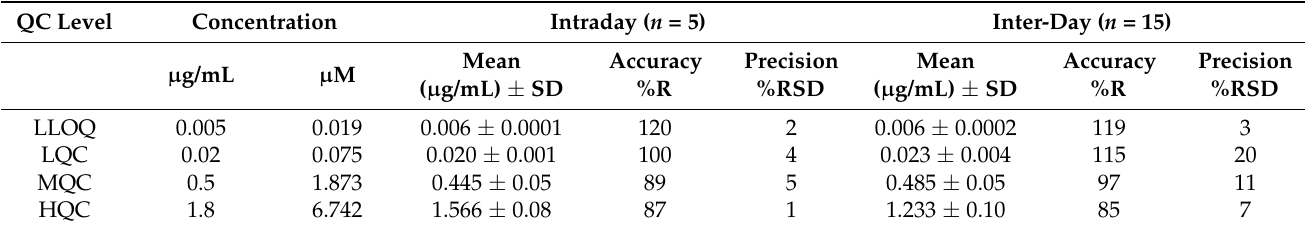
Table 2. Intra- and inter-day precision and accuracy of adenosine in spiked blood samples at four concentration levels. QC Level